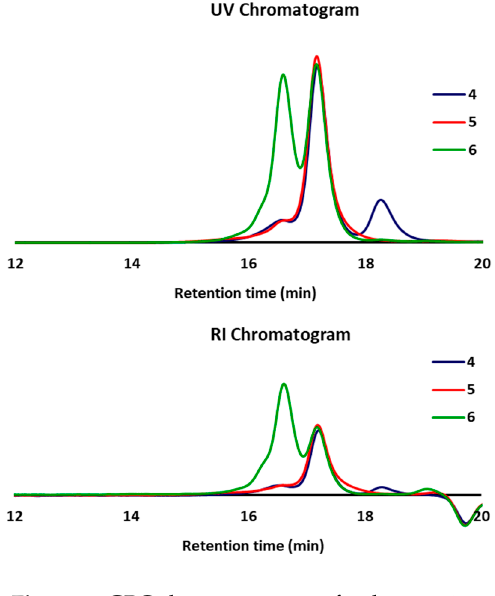
Figure 1. GPC chromatograms of polymers 4 – 6 .